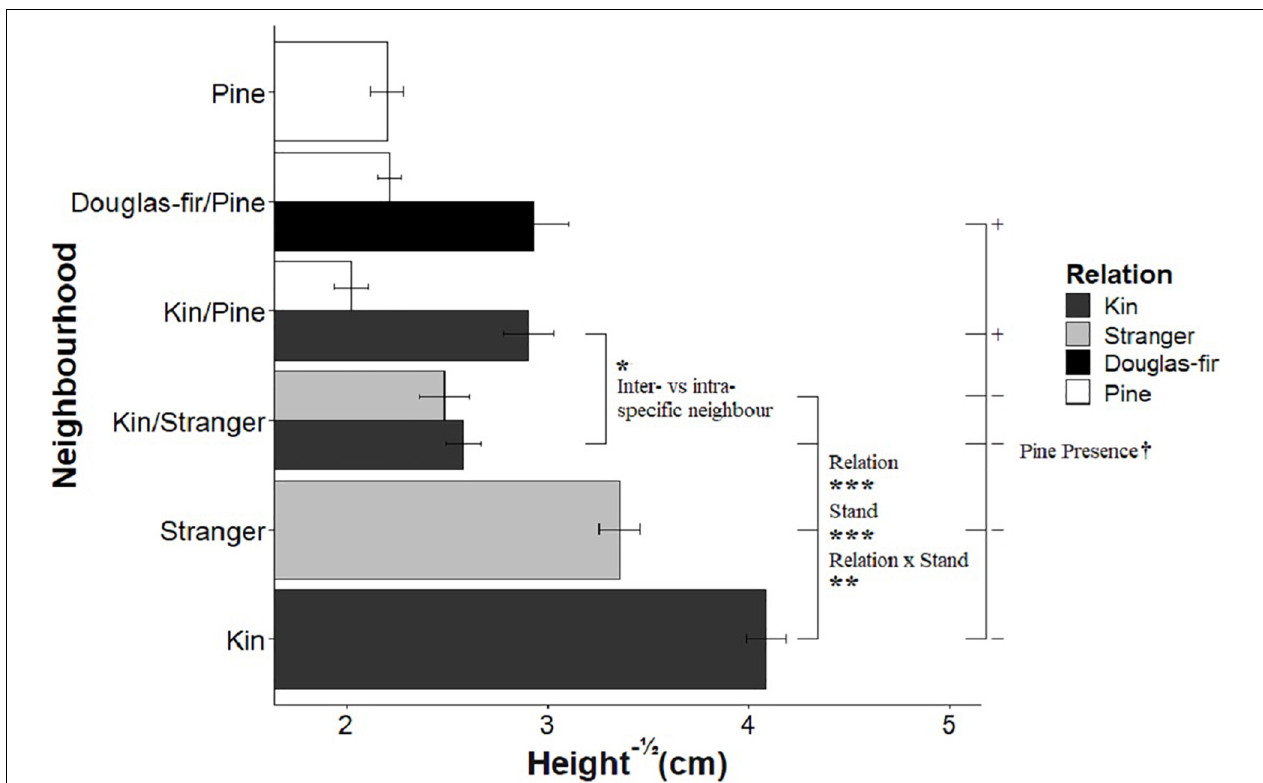
FIGURE 3 | The effect of neighborhood treatments on the square-root of height for Douglas-fir seedlings (shaded) and pine seedlings (white). Significant planned contrasts are shown. Relation contrasted kin with stranger seedlings (estimate = –0.825, t ratio = –3.98, p = 0.0001, Df = 206). Stand contrasted seedlings grown in pure stand with those in mixed stands (estimate = 2.38, t ratio = 11.5, p < 0.0001, Df = 206). Relation × stand interaction was also significant (estimate = –0.637, t ratio = –3.07, p = 0.0024, Df = 206). The inter- vs. intraspecific neighbor contrasted kin seedlings neighbored by stranger Douglas-fir with pine seedlings (estimate = 0.324, t ratio = 2.12, p = 0.0350, Df = 206). The pine presence contrasted Douglas-fir seedlings grown with a pine neighbor vs. without a pine present in the pot (estimate = –0.425, t ratio = –1.78, p = 0.0764, Df = 206). Pine seedlings grown with a pair of kin had less biomass than those grown in pairs of pine with a single Douglas-fir and less than pine grown in pure pine stands. * p < 0.05, ** p < 0.01, *** p < 0.001, and † p < 0.1.